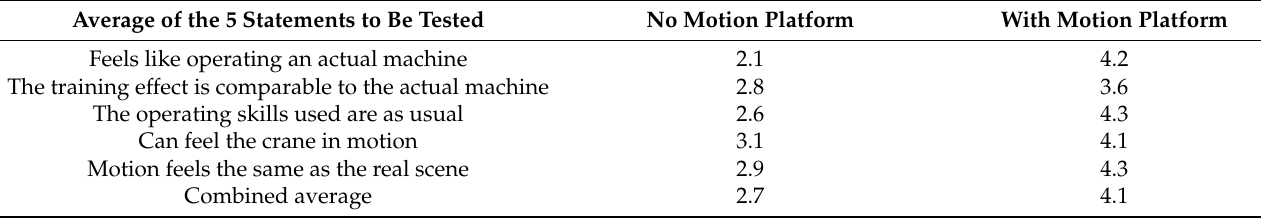
Table 3. Controlled subjective evaluation test